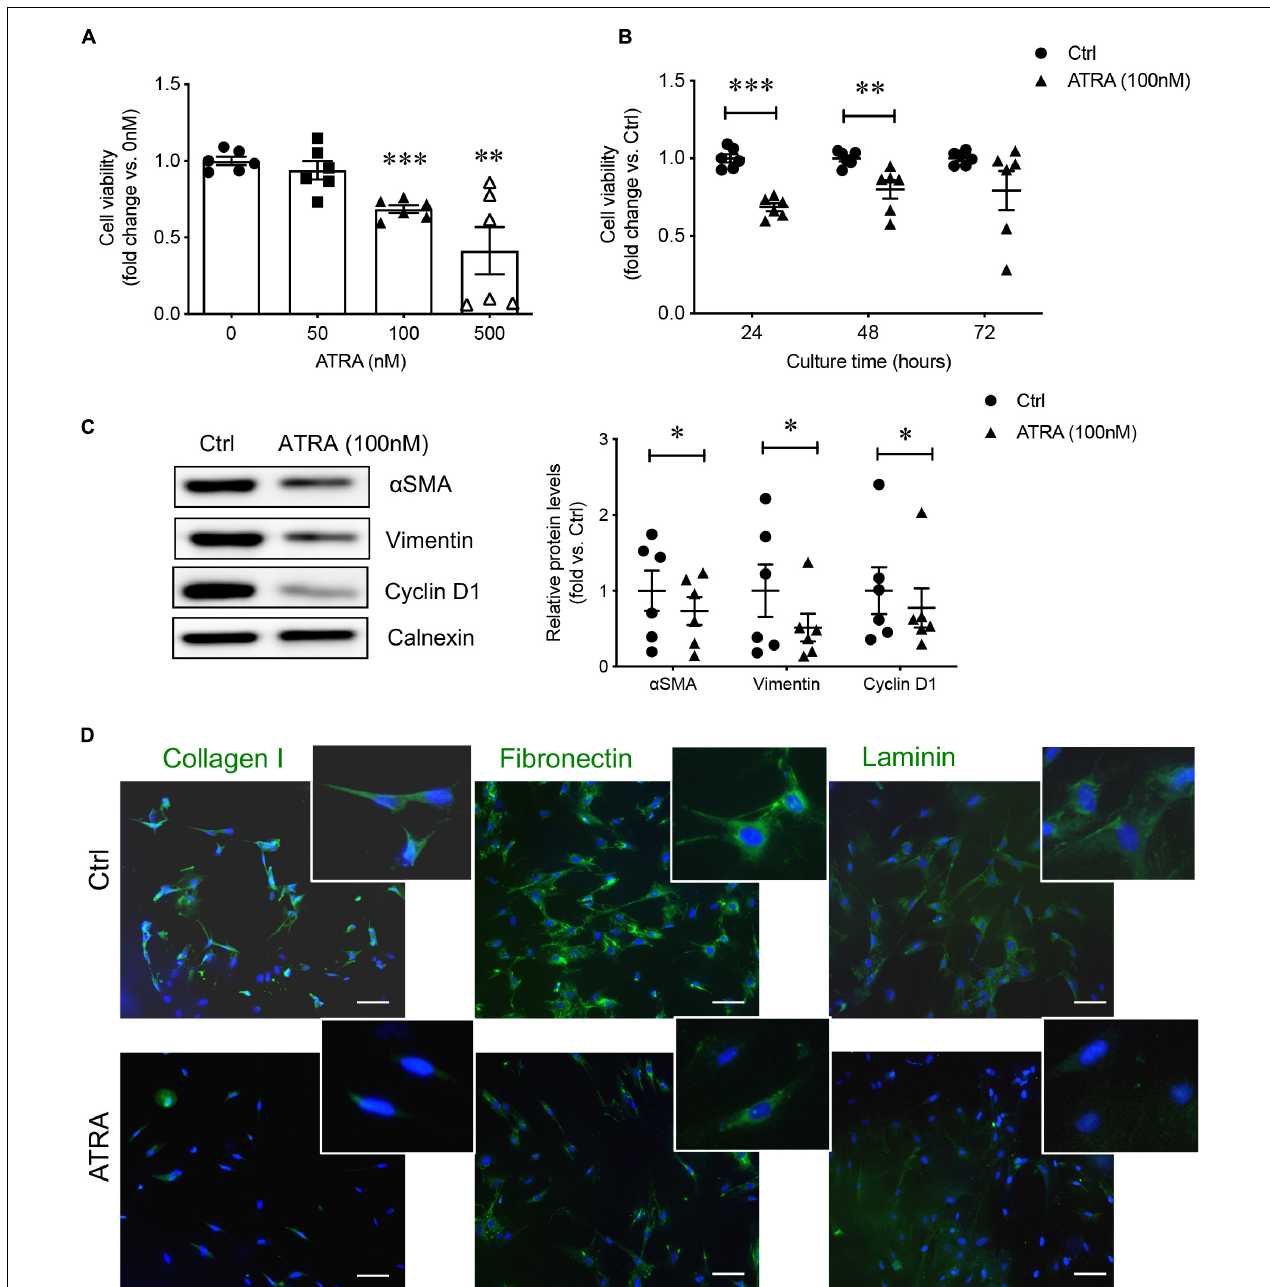
FIGURE 4 | Activation of PaSCs was significantly reduced under 100 nM ATRA treatment. (A) Dose- and (B) time-dependent studies examining the effect of ATRA on PaSC viability by MTT assay. (C) Western blot analysis of activated PaSCs ( α SMA, vimentin) and proliferation of PaSCs (cyclin D1) after 48 h treatment with 100 nM ATRA, normalized to the reference protein calnexin. Closed circles, control group; closed triangle, ATRA treated group. Data are normalized to control and expressed as fold changes (mean ± SEM, n = 4–6 experiments/treatment group). ∗ p < 0.05, ∗∗ p < 0.01; ∗∗∗ p < 0.001 vs. control; analyzed using paired Student’s t -test. (D) Representative in situ immunofluorescence staining images of extracellular matrix proteins in cultured PaSCs of control and ATRA treated groups. Scale bar: 100 µ m. Magnified images are shown in